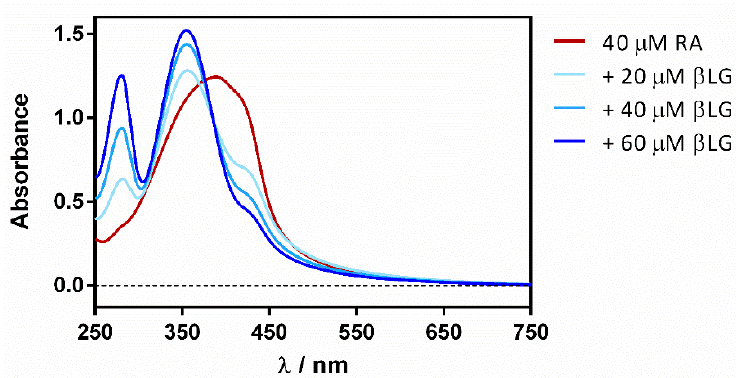
Figure 4. β LG addition effect on the absorption spectrum of free RA in PBS.